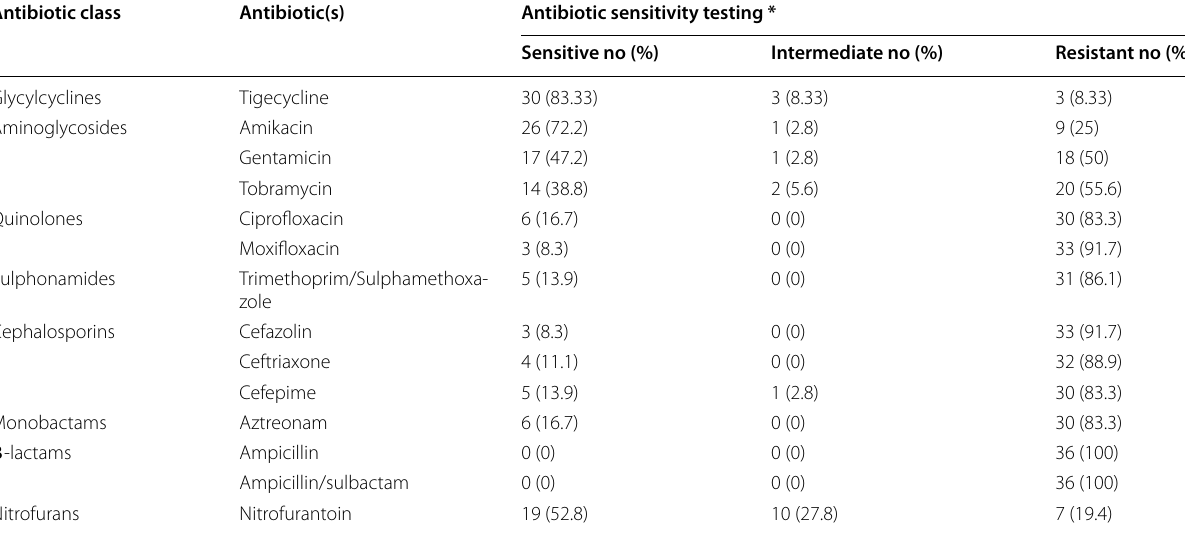
* Antibiotic sensitivity testing all results were interpreted according to CLSI 2022 except for tigecycline and moxifloxacin, they were interpreted according to EUCAST 2022 [8, 10]